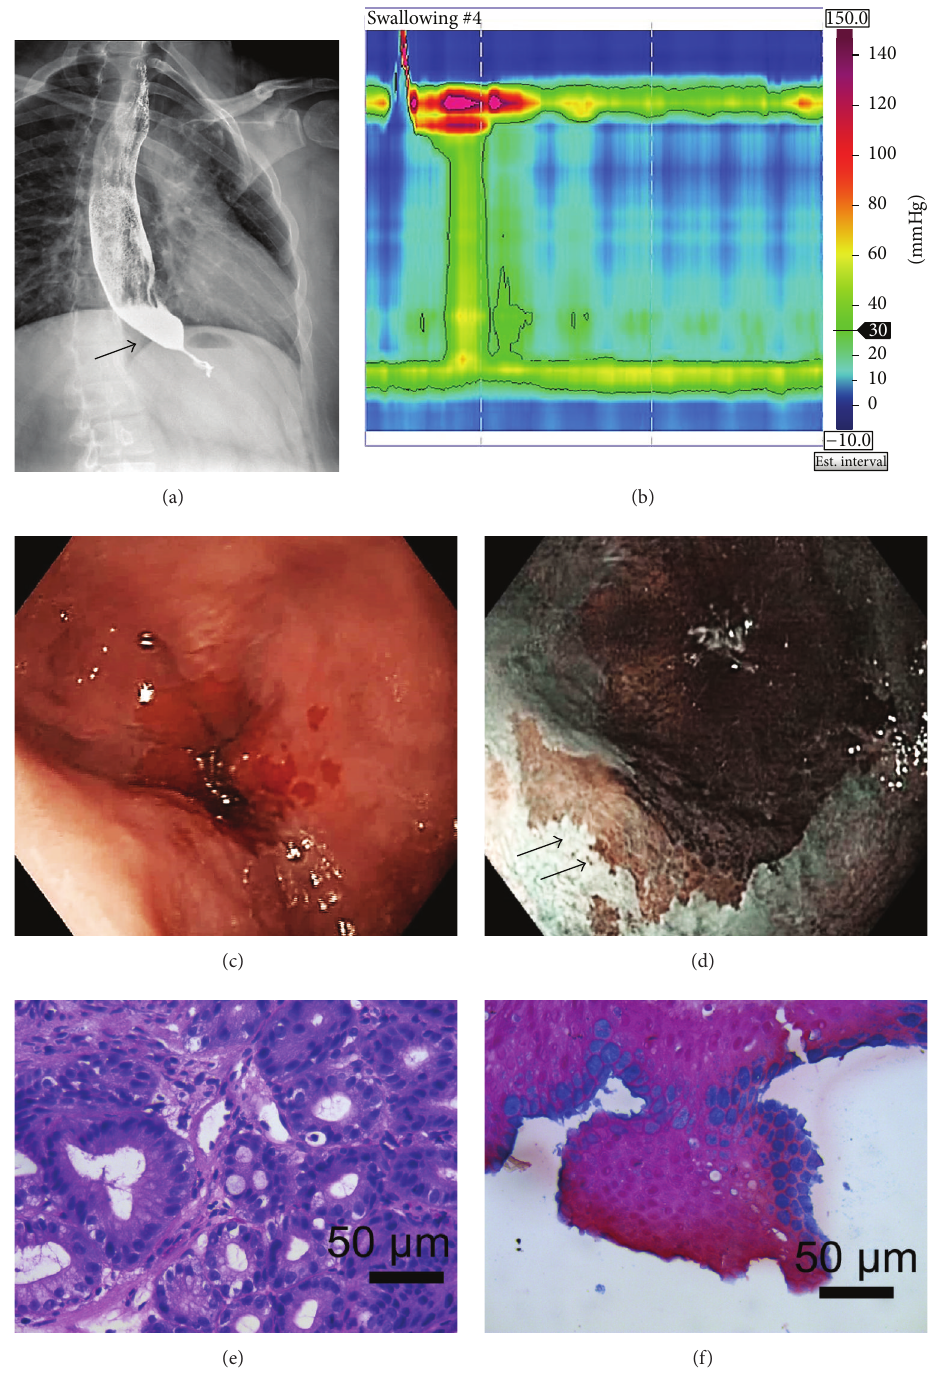
Figure 1: (a) Barium oesophagram that shows dilatation and bird beak sign (arrow). (b) High resolution manometry that shows abnormal relaxation of lower oesophageal sphincter and aperistalsis with panesophageal pressurization in 40% of swallows, corresponding with type II achalasia. (c) Upper endoscopy shows dilated esophagus with mucosal changes consistent with C0 M1 Barrett’s oesophagus. (d) Arrows indicate margins of “tongues” of Barrett’s metaplasia. (e) Metaplastic columnar epithelium. (f) Photomicrograph that highlights the metaplasia. Original magnification in high field power